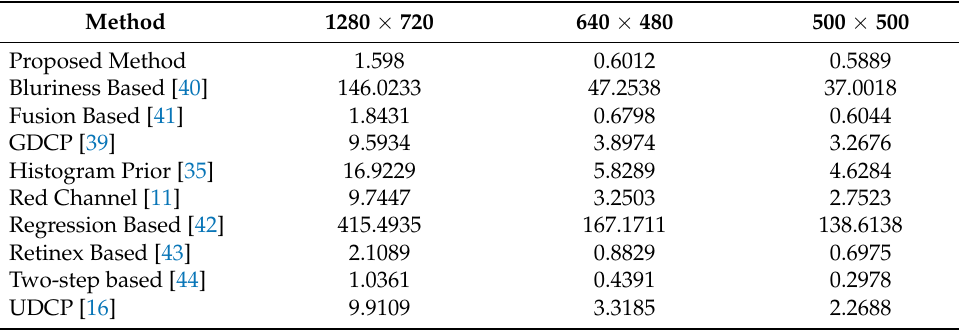
Table 6. Average Runtime for Different Image Sizes (In Table 7. Evaluation Metrics Comparison of UIQM Scores. Table 7. Evaluation Metrics Comparison of UIQM Scores.